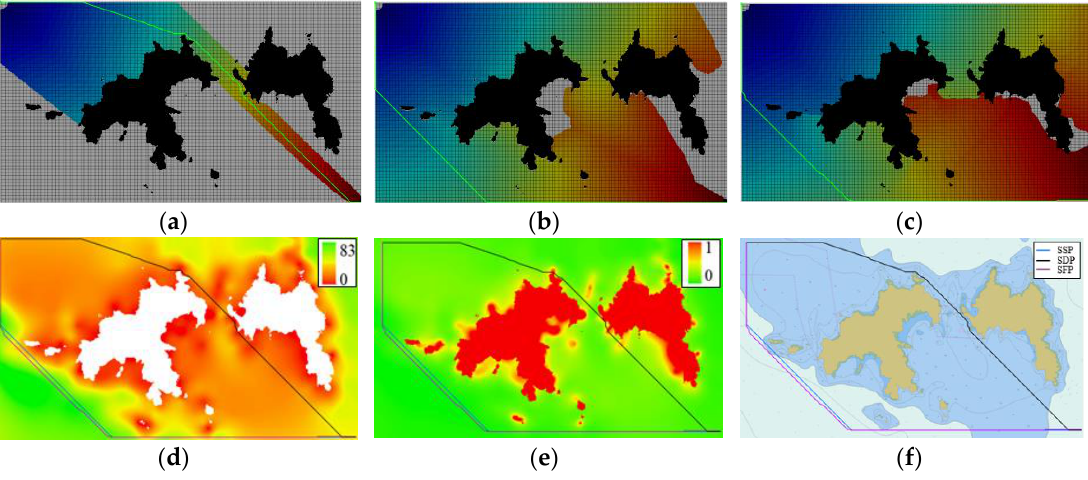
Figure 13. Comparison of three kinds path. ( a ) SDP that ignores the depth risk; ( b ) SSP that considers the depth risk level and distance. ( c ) SFP that considers only the depth risk. The colorful grids in figure ( a – c ) are extended nodes. The space of white grids represents the feasible space, and the black grids are obstacles. ( d ) Three paths, shown on the depth distribution map. ( e ) Three paths, shown on the depth risk level distribution map. ( f ) Three paths, shown on S57 ENC. The black line is the SDP, the blue one is SSP, and the purple one is SFP. Table 7. Comparison of di ff erent starting and goal